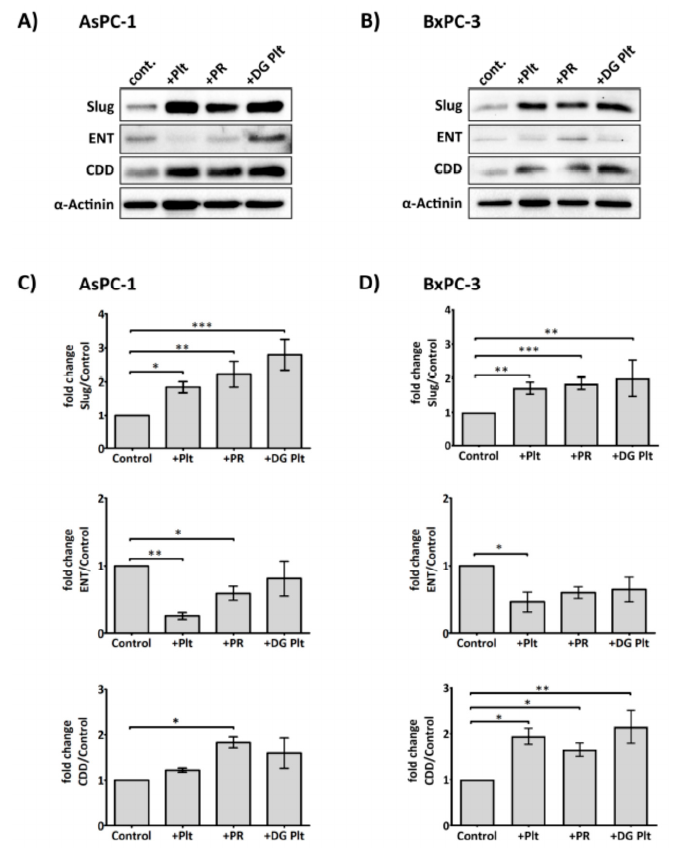
Figure 3. Platelets modulate the expression of Slug, human equilibrative nucleoside transporter 1 (hENT1) and cytidine deaminase (CDD) in PDAC cells. Representative immunoblots ( A ) and ( B ) show the expression of Slug, hENT1 and CDD in AsPC-1 and BxPC-3 after treatment with platelets (Plt), platelet releasate (PR) or degranulated platelets (DG Plt) for 24 h. PR and degranulated platelets (DG Plt) were isolated from activated platelets. Briefly, platelets (1 × 10 9 /mL) were aggregated by incubating with 1 µg/mL CRP for 30 min then the supernatant (i.e., PR) and the pellet (i.e., DG Plt) were separated by centrifugation (5000 g for 10 min). The pellet was resuspended in Tyrode’s buffer, using the initial volume. The cancer cells were seeded in a 6-well plate at 3 × 10 5 per well for 24 h, then incubated with Plt, PR or DG Plt to the final concentration equivalent to 1 × 10 8 platelets/mL for 24 h in serum-free media. Cell lysates were separated by SDS-PAGE and immunoblotted using specific antibodies for Slug, hENT1, CDD and loading control protein α -actinin. Bar graphs ( C ) and ( D ) show the changes in the expression of Slug, hENT1 and CDD in AsPC-1 and BxPC-3 after different treatments. The expression level of the protein of interest was quantified relative to the loading control and normalised to the negative control group ( n ≥ 3). Data are presented as mean ± SEM. One